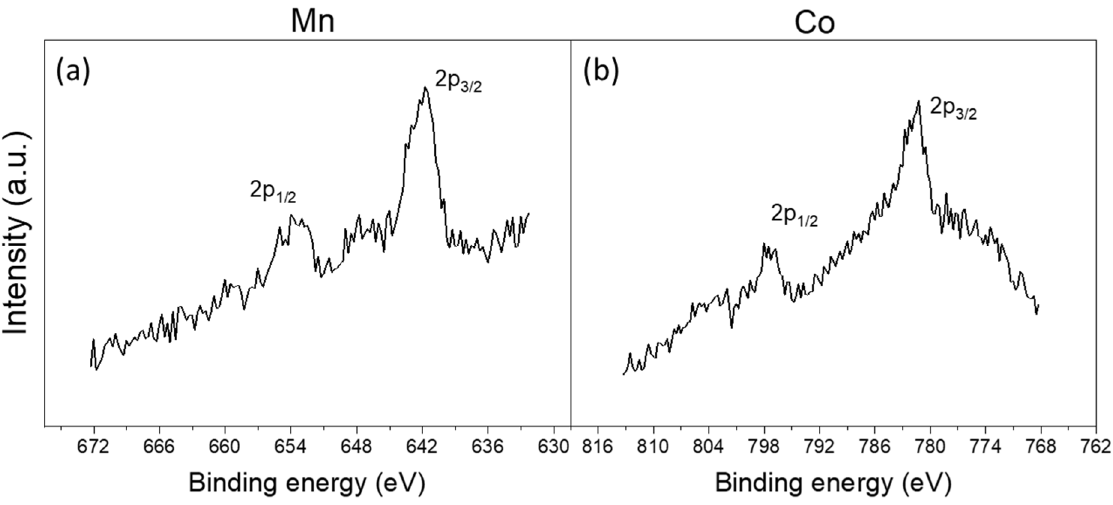
Figure 4. XPS detail spectra in the ( a ) Mn2p and ( b ) Co2p region. Prior to the discussion of the results it appears noteworthy that the peaks of transition metals with unpaired electrons (such as Mn 2+ to Mn 4+ as well as Co 2+ and Co 3+ ) show a complicated multiplet splitting due to coupling effects during the photo-ionization [20]. (Mn2p 3/2 ) and 654 eV (Mn2p 1/2 ), in the Co2p region (Figure 4b) they were found at ~782 eV (Co2p 3/2 ) and 797 eV (Co2p 1/2 ). No major satellite peaks were observed in both cases.